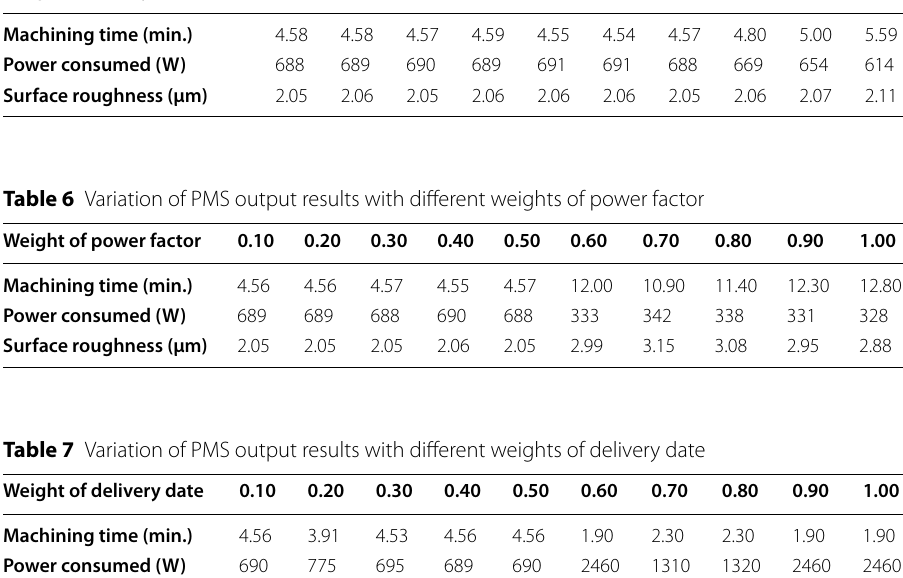
Table 5 Variation of PMS output results with different weights of quality of product Weight of quality of product 0.10 Machining time (min.) Power consumed (W) Surface roughness (μm)